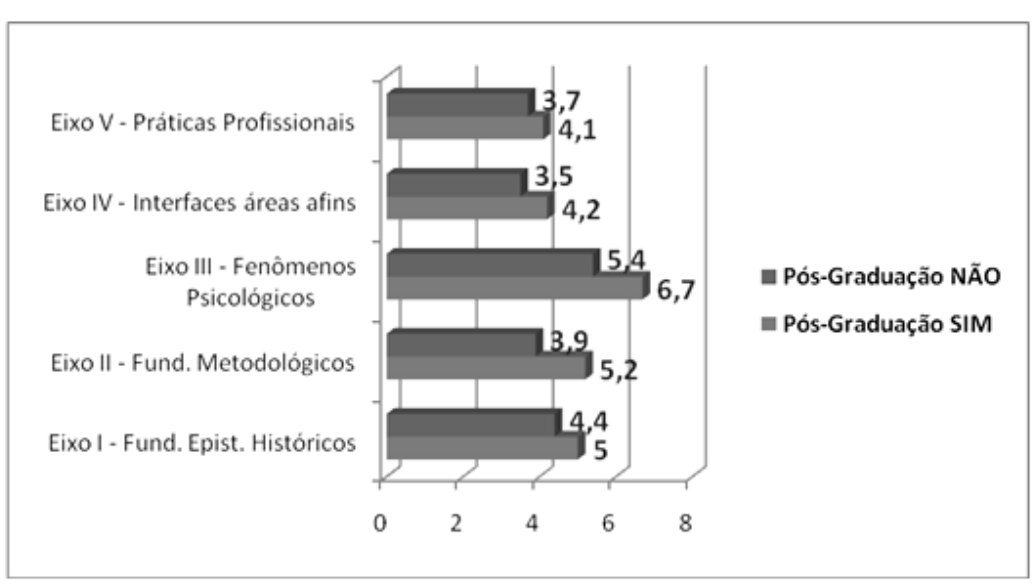
Figura 5 . Desempenho no ENADE 2006 das IES com e sem pós, por eixos estruturantes de formação. Retirado de Bastos (2007, slide 22)